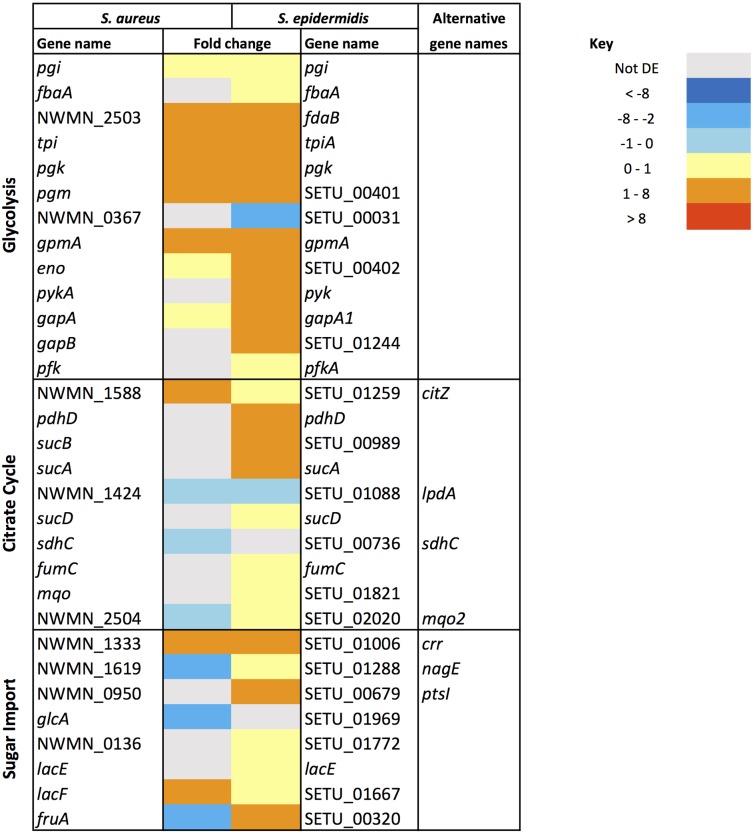
Changes in gene expression of carbon metabolism associated genes in S. aureus and S. epidermidis challenged with sapienic acid.